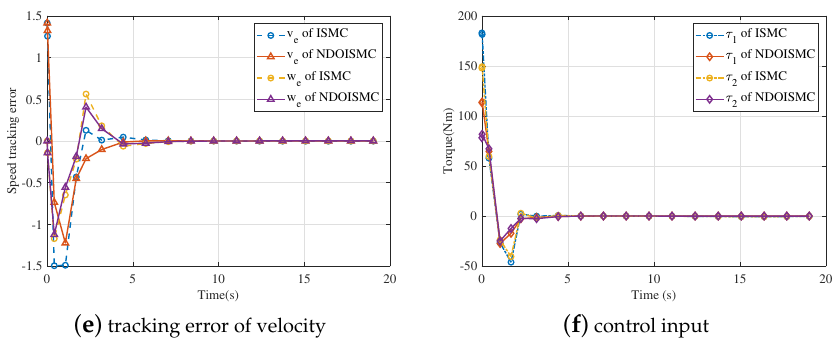
Figure 3. Comparative simulation results for linear trajectory tracking.